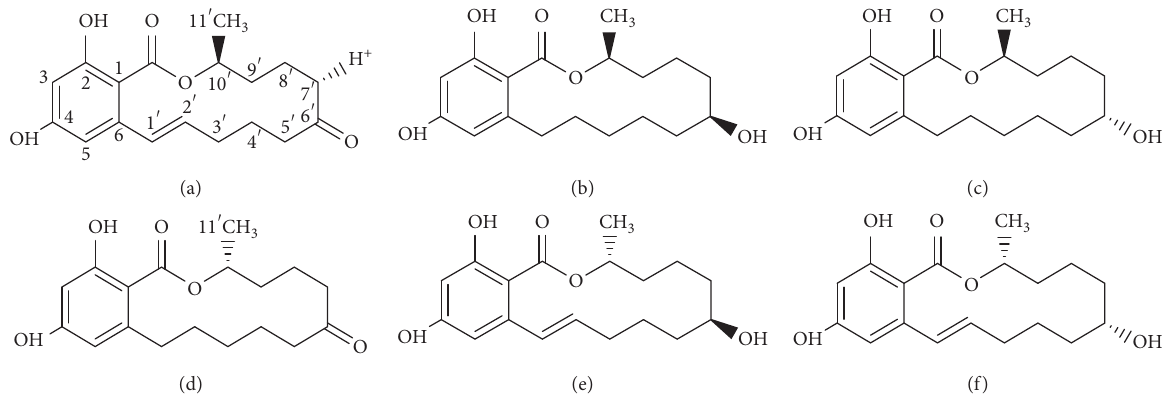
Figure 1: The chemical structure of zearalenone and its analogs. (a) Zearalenone (ZEN). (b) Alpha-zearalanol ( α -ZAL). (c) Beta-zearalanol ( β -ZAL). (d) Zearalanone (ZON). (e) Alpha-zearalenol ( α -ZOL). (f) Beta-zearalenol ( β